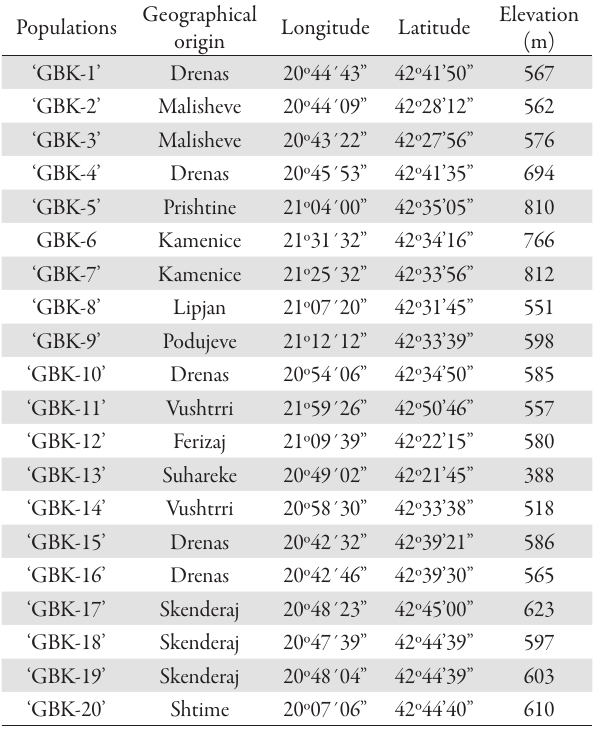
Tab. 1. Geographical data of investigated Kosovo local maize